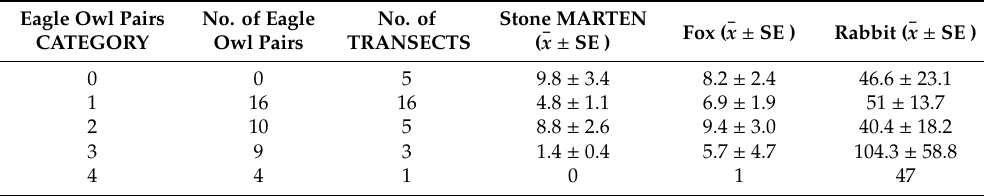
Table 1. Summary of the number of transects where a di ff erent number of pairs of eagle owl were heard using acoustic census, as well as of the average number of stone marten scats, fox scats, and rabbit latrines per transects grouped by pairs of